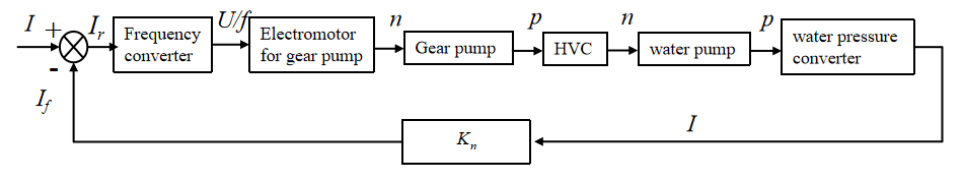
Figure 1. Diagrammatic sketch of HVD control system.